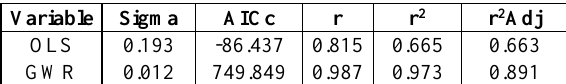
Table 2. The Diagnostic statistics for parameters from GWR